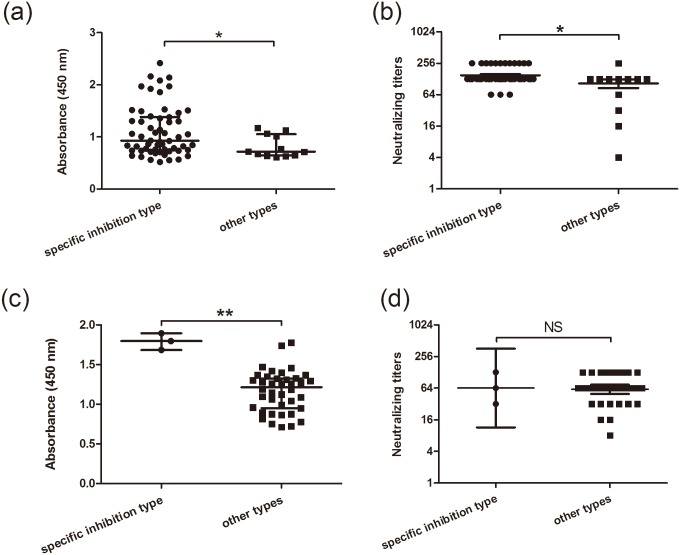
Characterization of antibody reactivity against CA16 VP1 and the anti-CA16 neutralizing titres of 70 and 43 serum samples strongly reactive against VP1 from the Shanghai blood donors (a and b) and Shanxi individuals (c and d).The samples strongly reactive against VP1 were divided into two groups: the specific inhibition type (the anti-CA16 VP1 reaction were completely inhibited by VP11-60 and VP141-297) and the other types. The specific inhibition type and the other types include 48 and 12 serum samples in the Shanghai blood donors and 3 and 40 serum samples in the Shanxi individuals, respectively. Statistical significance was tested using the independent samples t test and Wilcoxon rank sum test. * indicates p<0.05, ** indicates p<0.001, “NS” represents no significant difference (p>0.05).